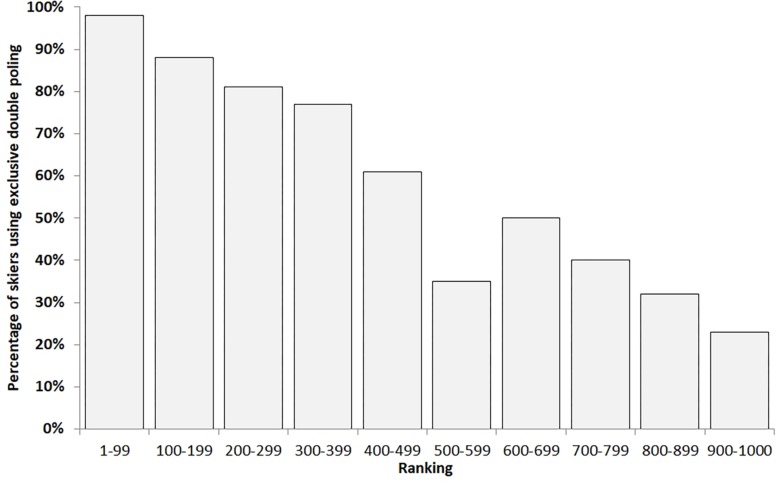
Percentage of skiers that used exclusive double poling (DP) during the first uphill (also assuming exclusive DP for the entire race) within performance groups in steps of 100 as based on their position during the uphill.